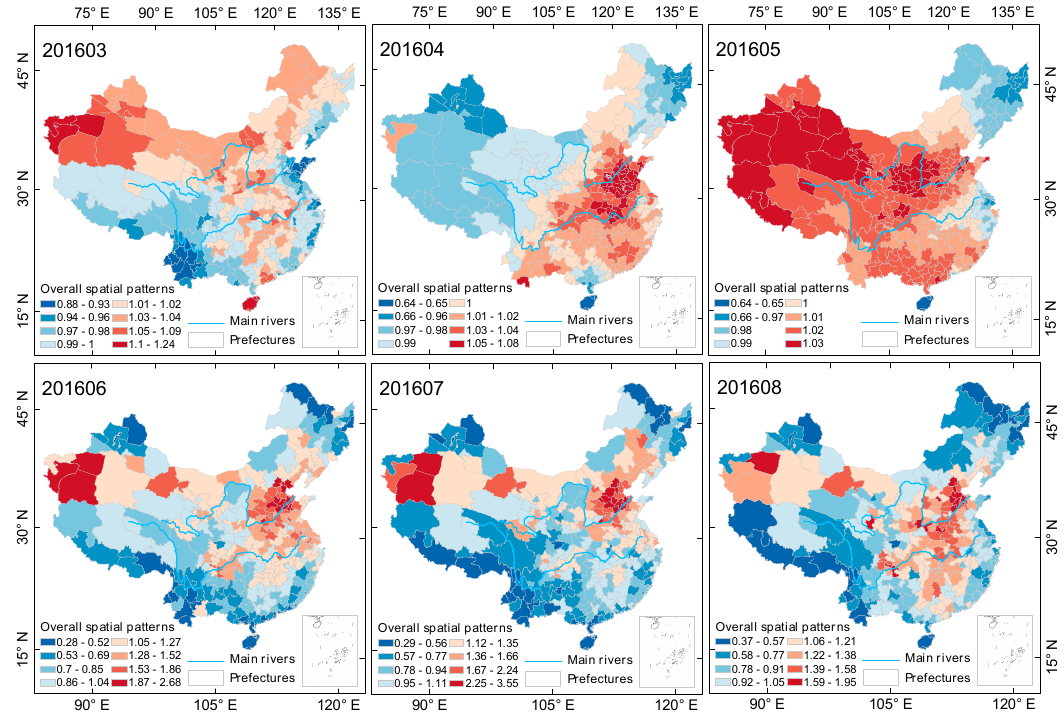
Figure 9. Evolution of spatial relativity of PM 2.5 pollution over the Chinese mainland (not including Taiwan) during the spring-summer season of 2016.